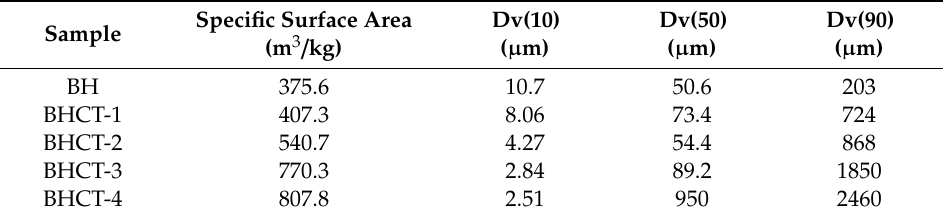
Table 2. Particle-size distribution of composite gel under different crosslinker concentrations.